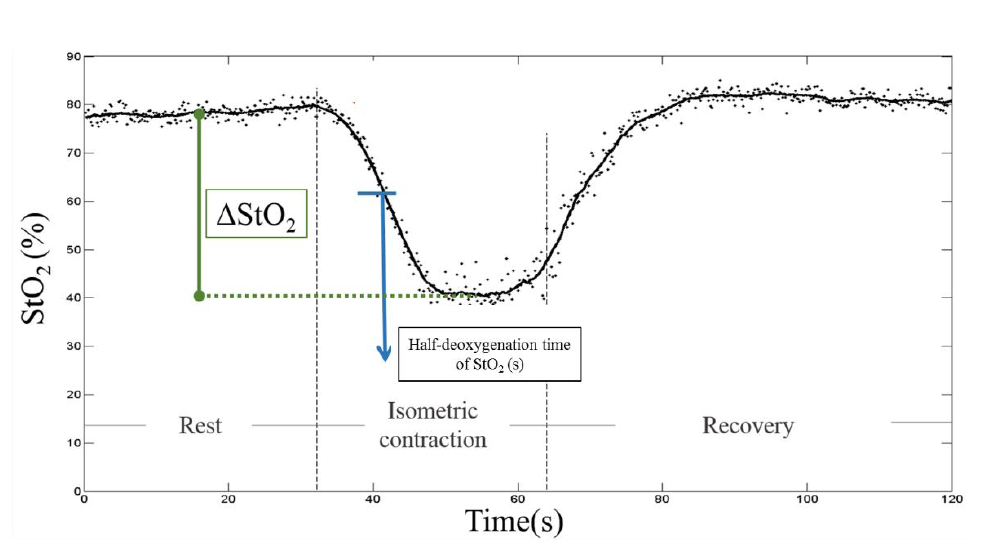
Figure 2. A representative example of time-domain analysis of muscular oxygenation kinetics. The oxygen saturation expressed as ([ HbO 2 ] / [ tHb ]) × 100% was adopted and a hyperbolic tangent equation with the least-square error method was applied to fit the oxygen saturation curves as a function of time during the contraction and recovery periods.